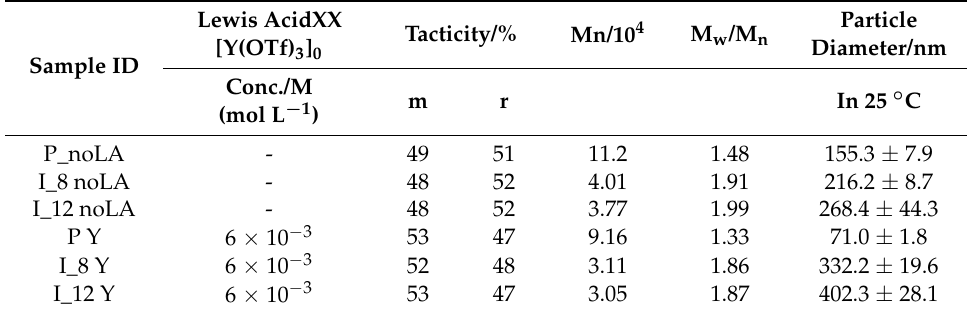
Table 1. Properties of P(nipam-co-IAM) by reversible addition-fragmentation chain-transfer